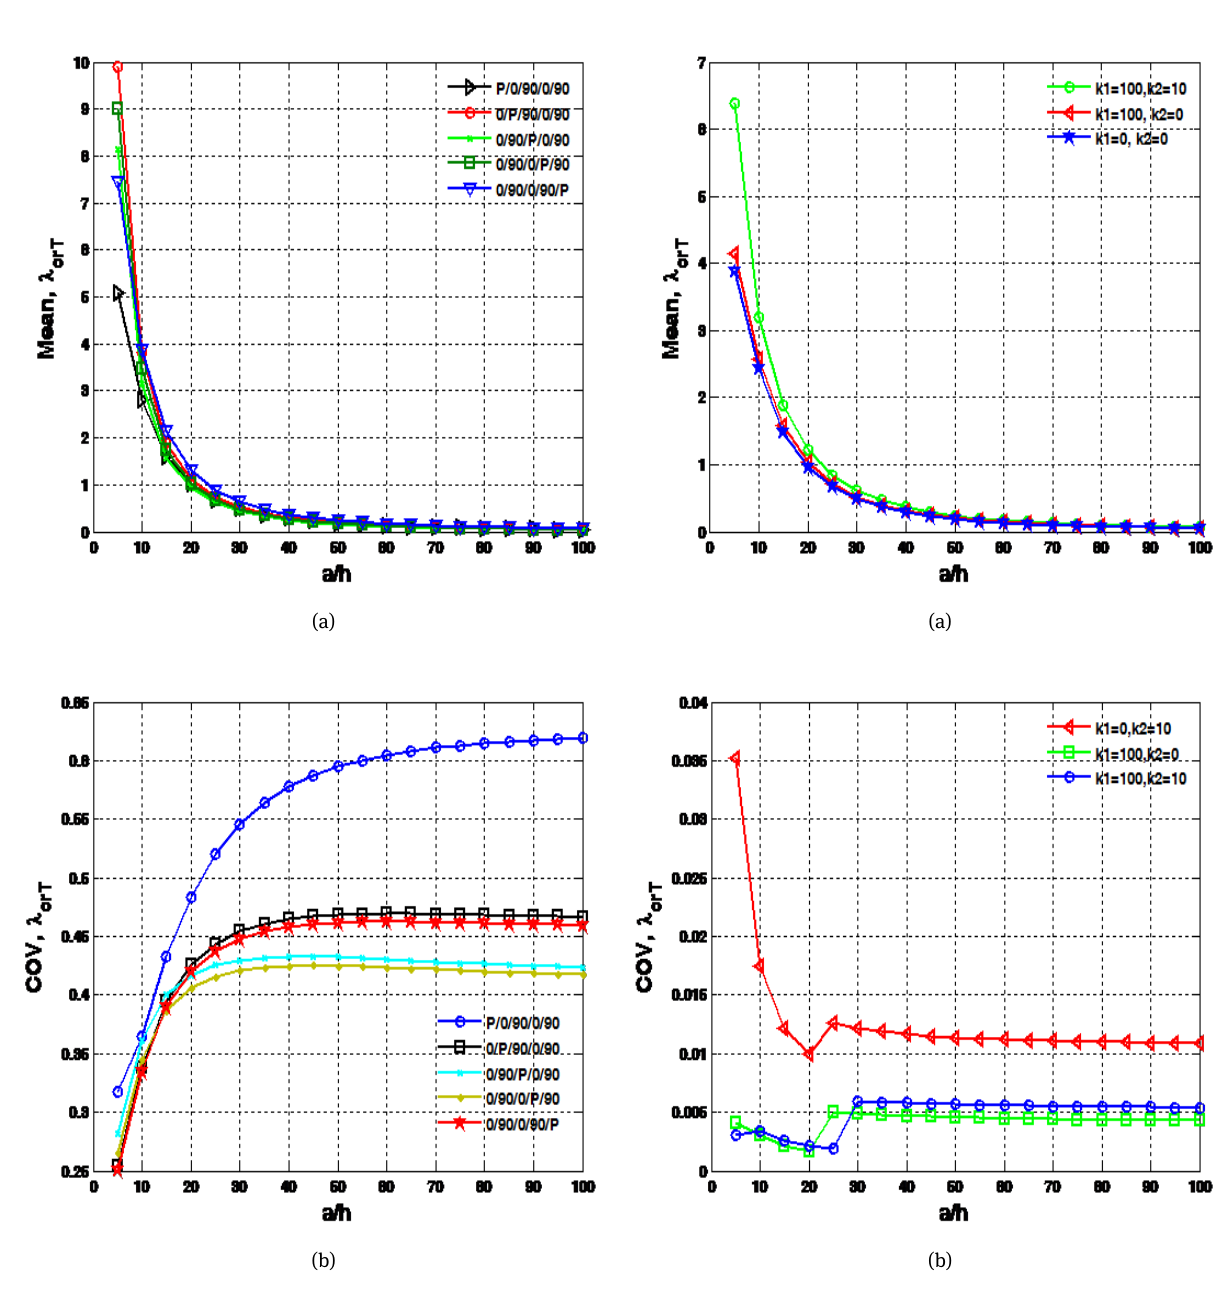
Figure 7: Effect of position of piezoelectric layer at various position of fiber layers and plate thickness ratios with random change in all system parameres on mean (a) and (b) COV of buckling temperature.